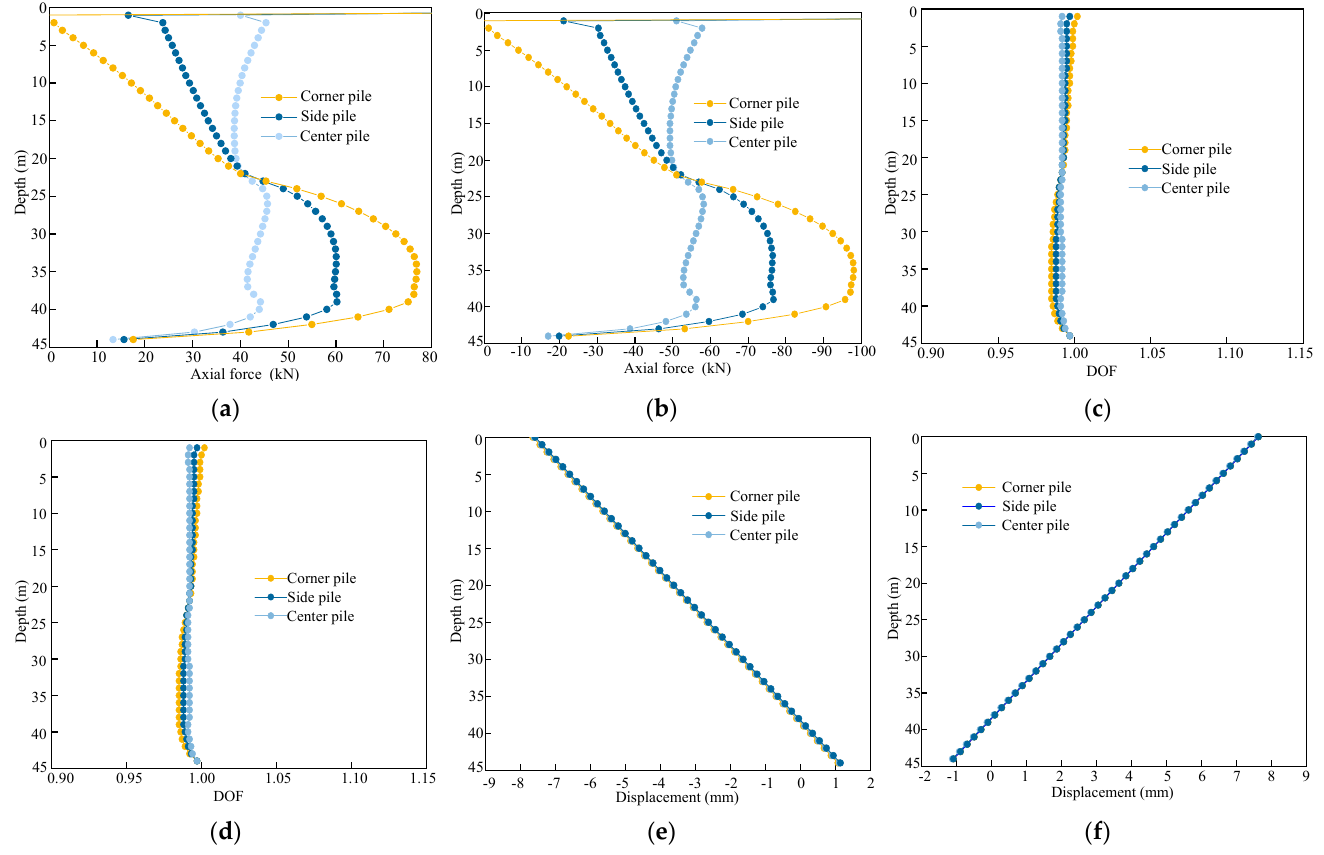
Figure 12. Temperature axial force, DOF and displacement of each energy pile. ( a ) Temperature axial force (summer). ( b ) Temperature axial force (winter). ( c ) The DOF distribution (summer). ( d ) The DOF distribution (winter). ( e ) Temperature displacement (summer). ( f ) Temperature displacement (winter).